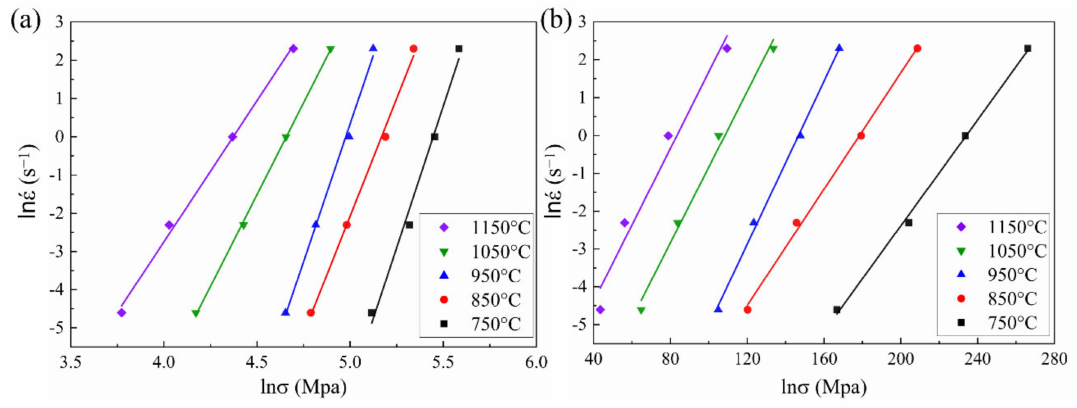
. . ε − ln σ and ln ε − σ as the strain is